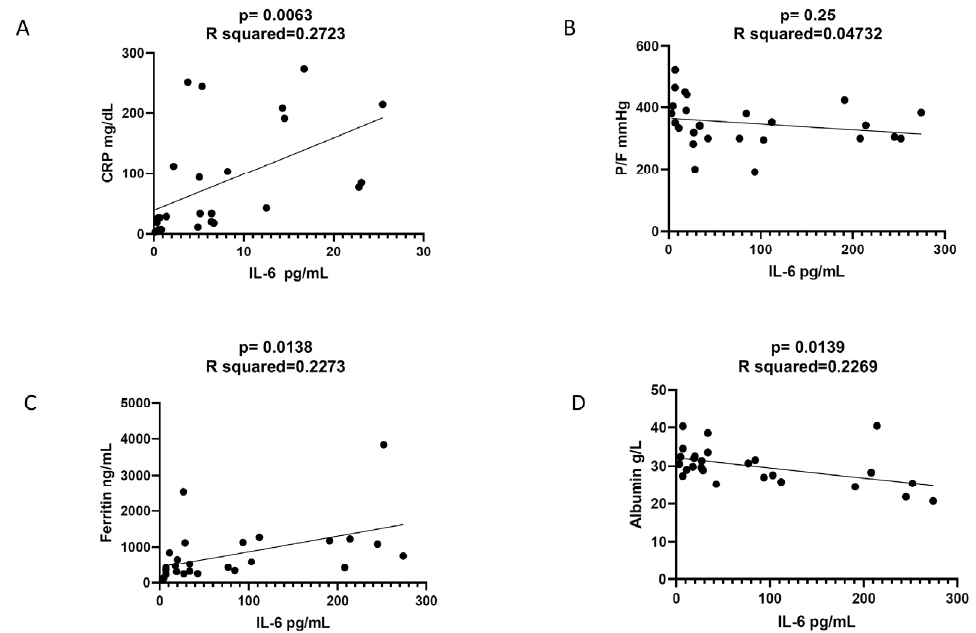
Figure 2. Simple linear regression analysis. ( A ) Significant correlation between IL ‐ 6 and CRP; ( B ) no correlation between IL ‐ 6 and P/F ratio; ( C ) significant correlation between IL ‐ 6 and ferritin; ( D ) inverse relationship between IL ‐ 6 and albumin. Table 2. Baseline characteristics of CHD patients affected by SARS ‐ Cov ‐ 2 pneumonia and divided into patients who survived and non ‐ survivors.